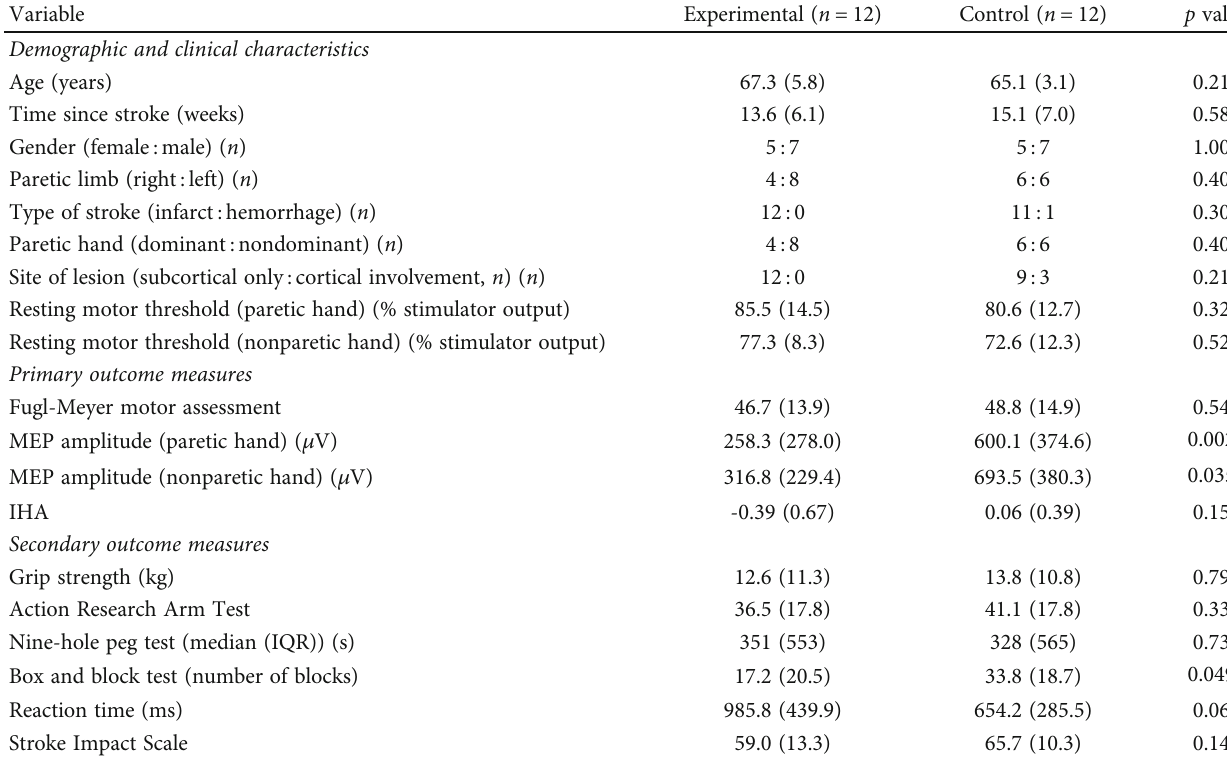
Table 1: Demographic and clinical characteristics of